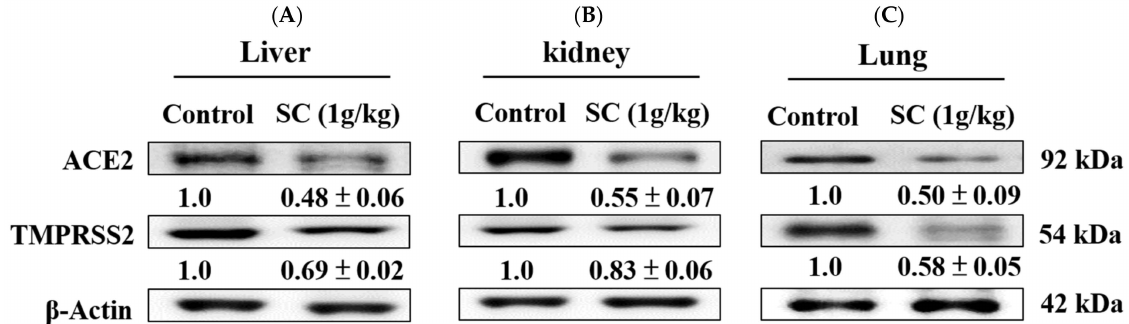
Figure 7. SC inhibited the ACE2 and TMPRSS2 expression in the liver ( A ), kidney ( B ), and lung ( C ) tissues in mice. Protein levels of ACE2 and TMPRSS2 expression in the liver and kidney tissues were assessed using Western blot. The densitometric analysis of protein bands is presented as a ratio (SC/control). Data are the means ± SD ( n = 3). β -actin was used as a positive control.